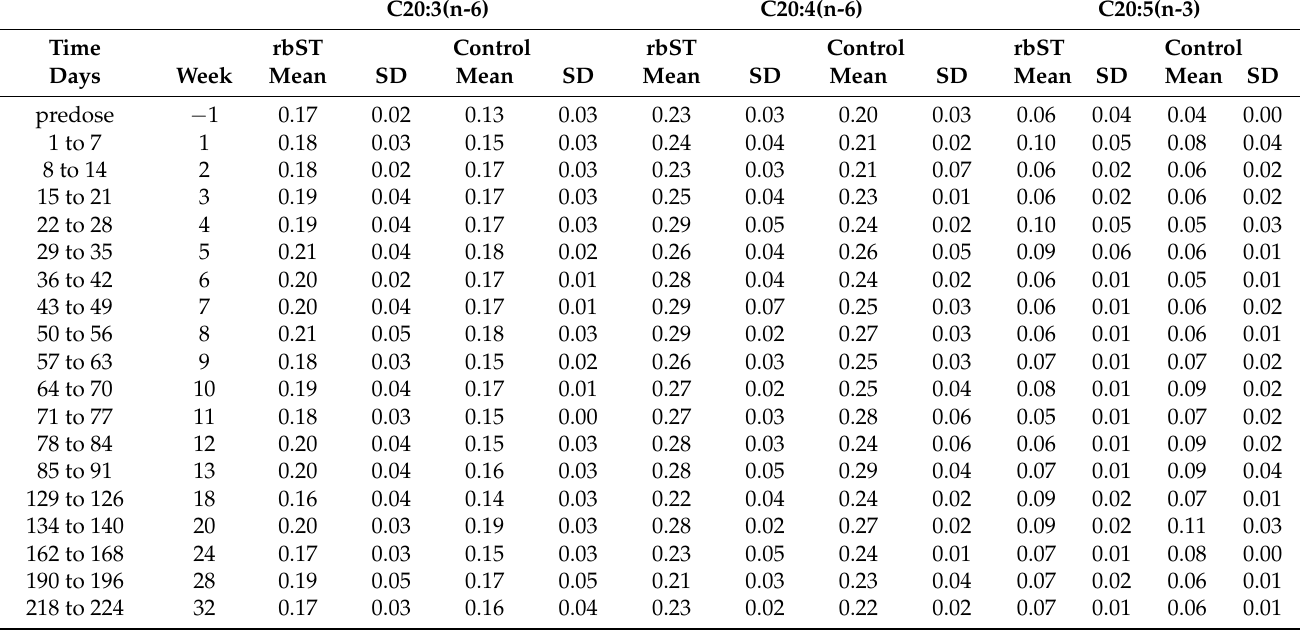
Table 7. Polyunsaturated fatty acids with 20 carbons in milk (% w / w of total fatty acids) obtained from cows treated with recombinant bovine somatotropin (rbST) ( n = 6) and from control animals ( n = 3) at different time points selected over the course of 37 weeks (8 injections of Lactotropina manufactured by Elanco, Eli Lilly,